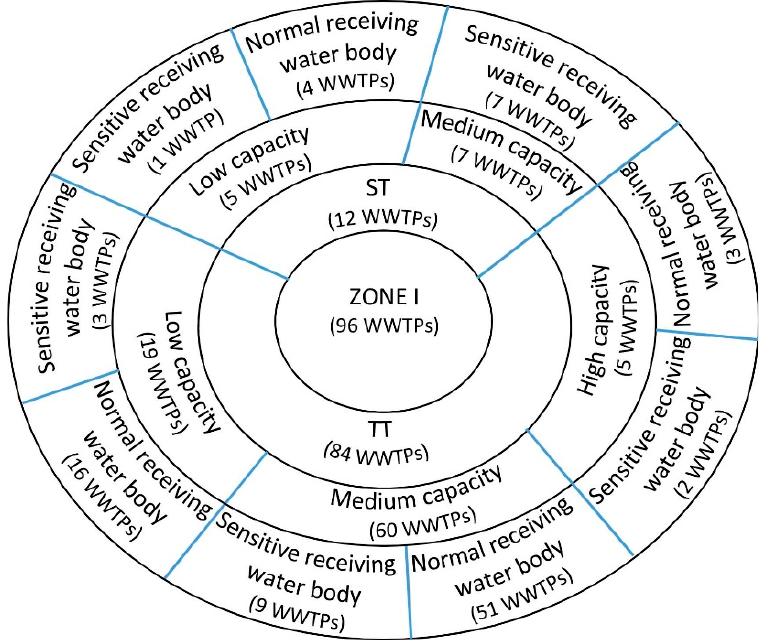
Figure 1. Categorization of WWTPs for Zone I of EHZ.